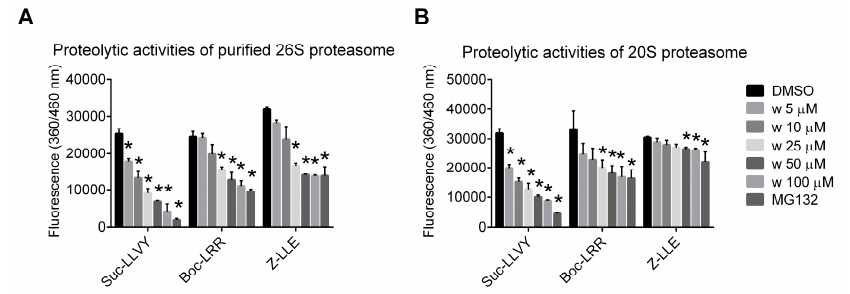
Figure 2. Wedelolactone inhibits chymotrypsin-like, trypsin-like, and caspase-like activities of purified 26S and 20S proteasome complexes in vitro. Wedelolactone (w) was added at various concentrations to reaction mixture containing either ( A ) 26S proteasome purified from MDA-MB-231 cells or ( B ) commercially available 20S proteasome, and fluorogenic substrate (Suc-LLVY-AMC for testing chymotrypsin-like, Z-LLE-AMC for caspase-like, and Boc-LRR-AMC for trypsin-like activities). Fluorescence was measured after 1 h incubation. MG132 was used as a positive control. The data represent the mean values from three independent experiments. Error bars indicate the SD. * indicates a significant ( p < 0.05) difference in proteolytic activities between reaction mixtures